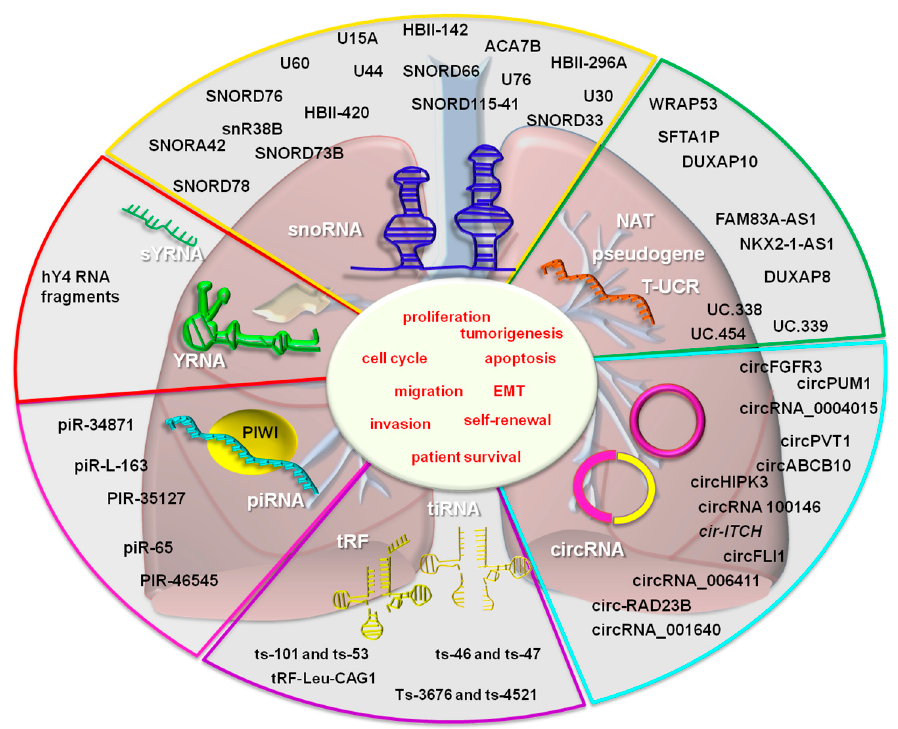
Figure 2. The lesser-known non-coding RNAs in lung cancer. The following non-coding RNAs function as tumor suppressors: ts-46, ts-47, ts-101, ts-53, ts-3676, ts-4521 (tRNA fragments), SNORD116-26, HBII-420, SNORD15A, SNORA42 (snoRNAs), piRNA-like-163, piR-35127, the piR-46545 (piRNA), CHIAP2, LOC100420907, RPL13AP17 (pseudogenes), and Uc.454 (T-UCR). The oncogenic non-coding RNAs from